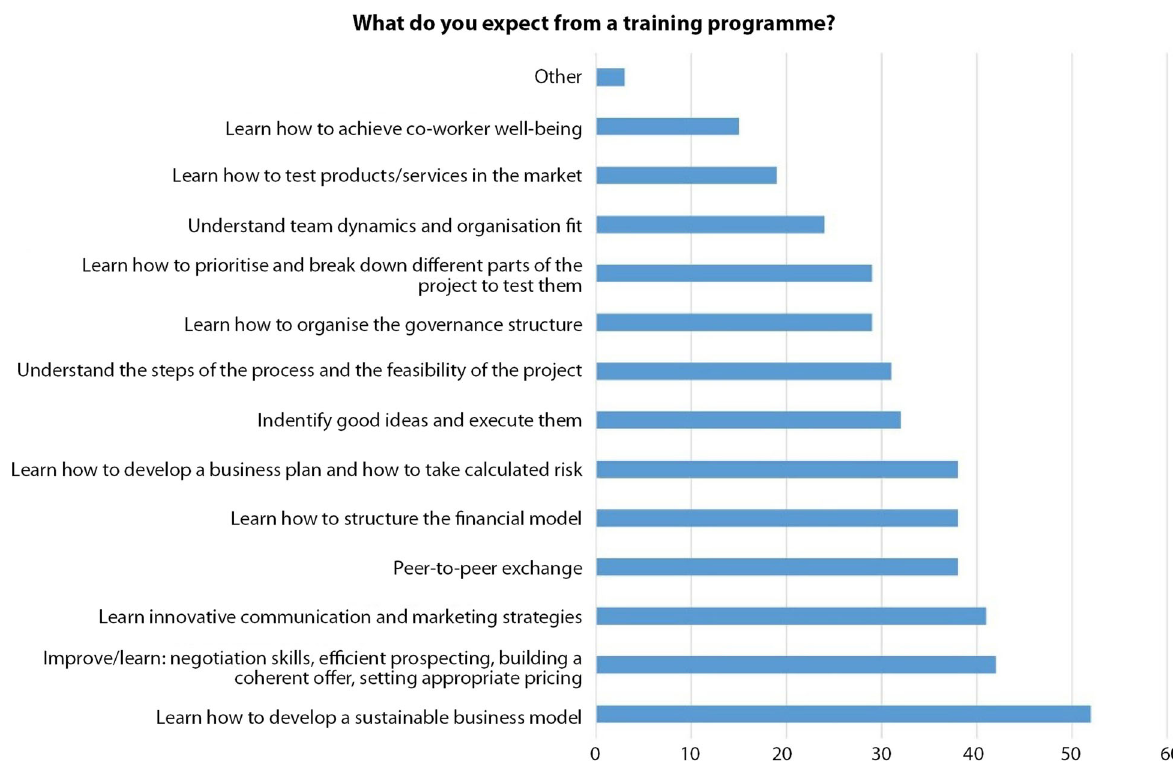
Fig. 15 What do you expect from a training programme? (Source: the